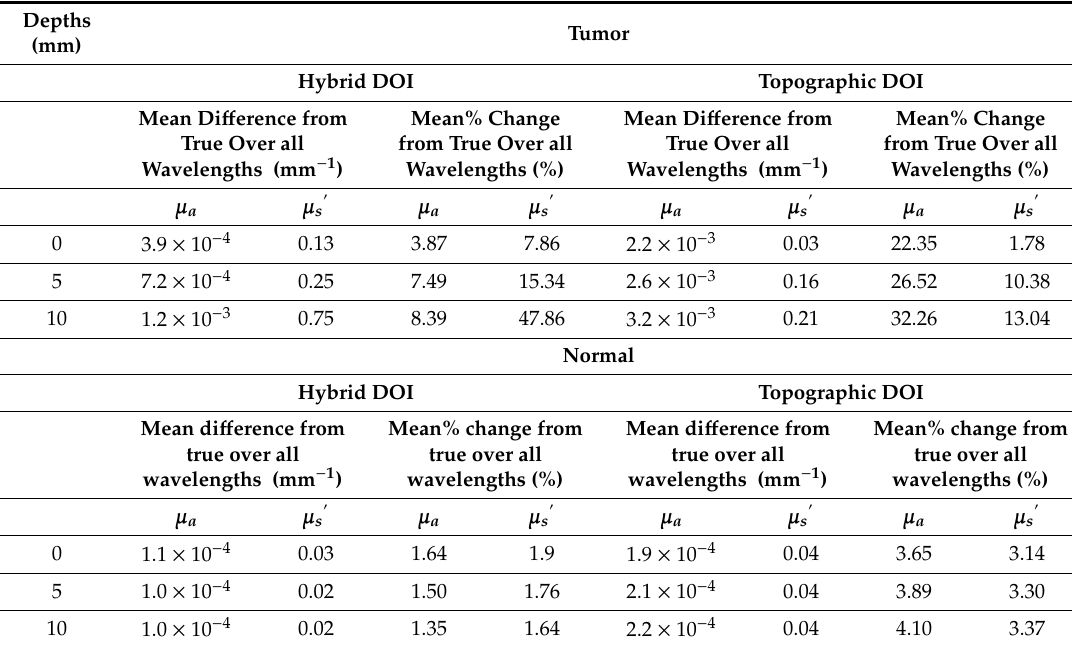
Table 3. Mean difference and mean percentage difference of recovered ( 𝜇 (cid:3028) , 𝜇 (cid:2929)(cid:4593) ) from true ( 𝜇 (cid:3028) , 𝜇 (cid:2929)(cid:4593) ) over all wavelengths.